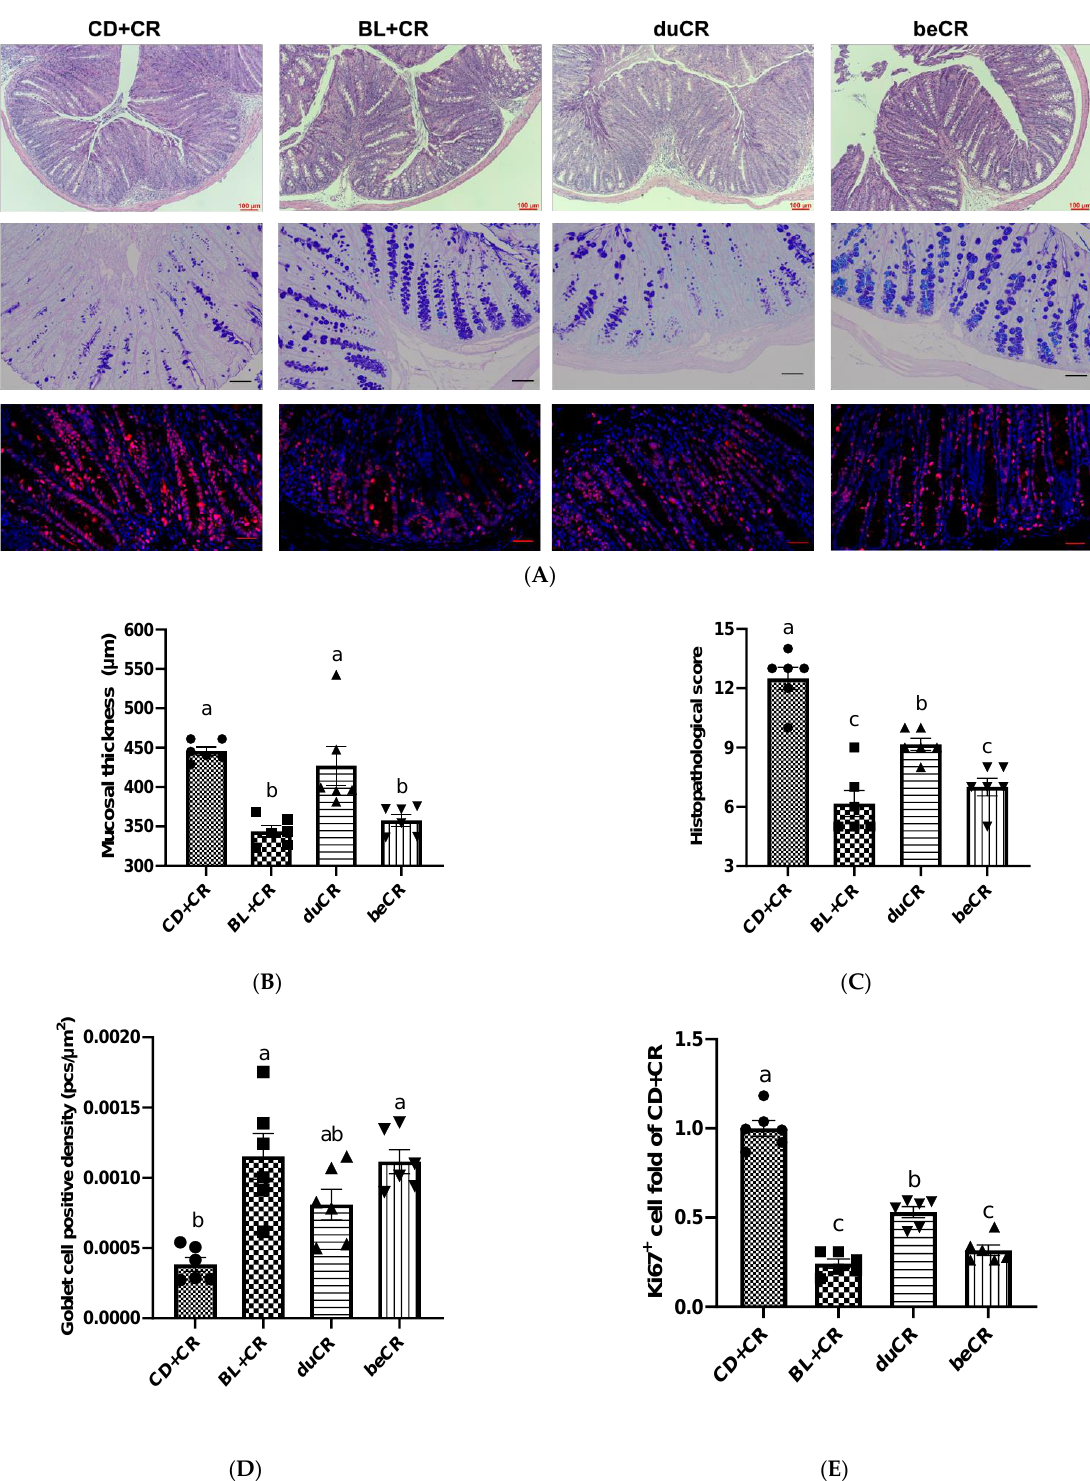
Figure 2. Effect of the beCR and duCR intervention on improving colonic histopathology. ( A ) Representative H&E staining images of colon tissues. Scale bar, 100 μ m. Representative Alcian blue staining images of colonic sections. Scale bar, 100 μm. Representative Ki67 -stained immunofluores- cence images of colon tissues. Ki67 immunofluorescence is indicated in red, and DAPI nuclear staining is blue. Scale bar, 50 μm . ( B ) Mucosal thickness. ( C ) Histopathology score of colonic section. ( D ) Goblet cell positive density. ( E ) Quantification of Ki67 positive cells. The a, b, c means in the same bar without a common letter differ at p < 0.05.